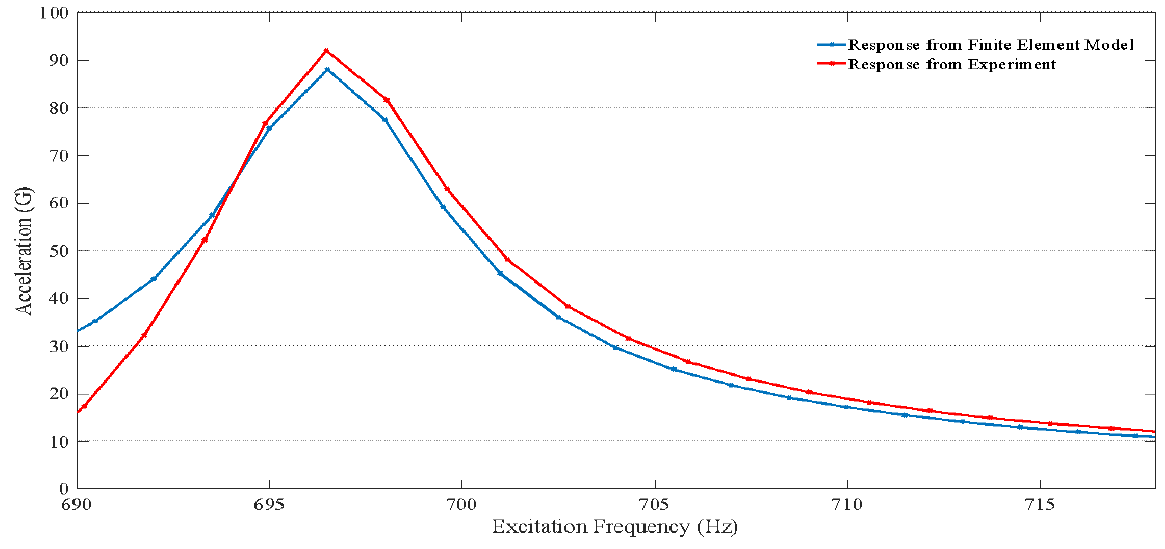
Figure 9. Frequency response function (FRF) of the test vehicle with a 1.6-mm board thickness.